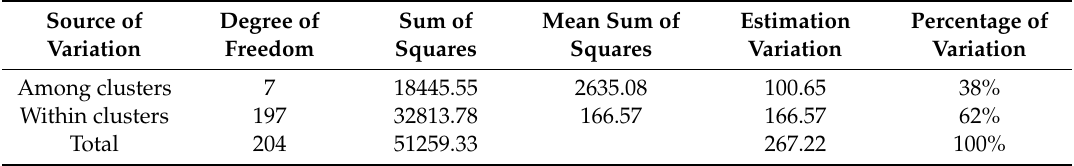
Figure 5. Cluster analyses of the 205 accessions of buffelgrass using the 1000 selected SNP markers. ( a ) Phylogenetic tree showing the genetic relationship of the accessions grouped into eight clusters, ( b ) probability of the accessions cluster membership, ( c ) identifying and assigning accessions into clusters, ( d ) PCA plot using Dim1 and Dim2, ( e ) Delta K suggesting two main groups, and ( f ) bar plots based on the admixture model in STRUCTURE. Table 1. Analysis of genetic differentiation among and within clusters of buffelgrass collection by analysis of molecular variance (AMOVA).